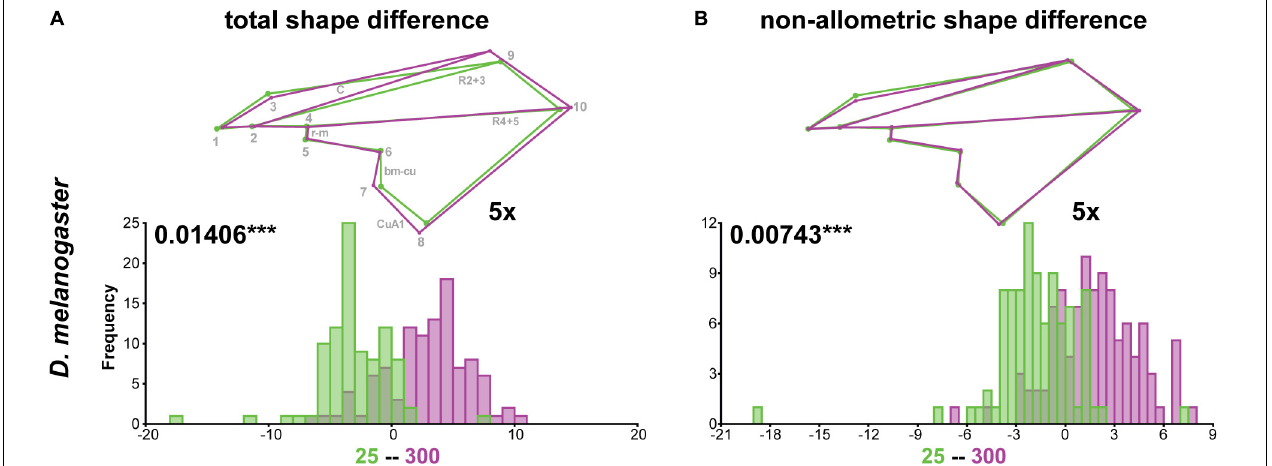
FIGURE 5 | Total and non-allometric shape differences in D. melanogaster due to different rearing densities. Summary of discriminant function analyses for total (A) and non-allometric (B) shape differences for flies raised at different densities. The wireframes represent differences between the low density (green) and high density (purple) average wing shapes. The scale factor is provided next to the wireframes. The magnitude of shape variation is indicated in units of Procrustes distance with the corresponding p -values based on 1,000 random permutations (*** P ≤ 0.001). Histograms with the distributions of the discriminant scores show shape separation into two distinct groups for each species. See also Supplementary Table 5 for